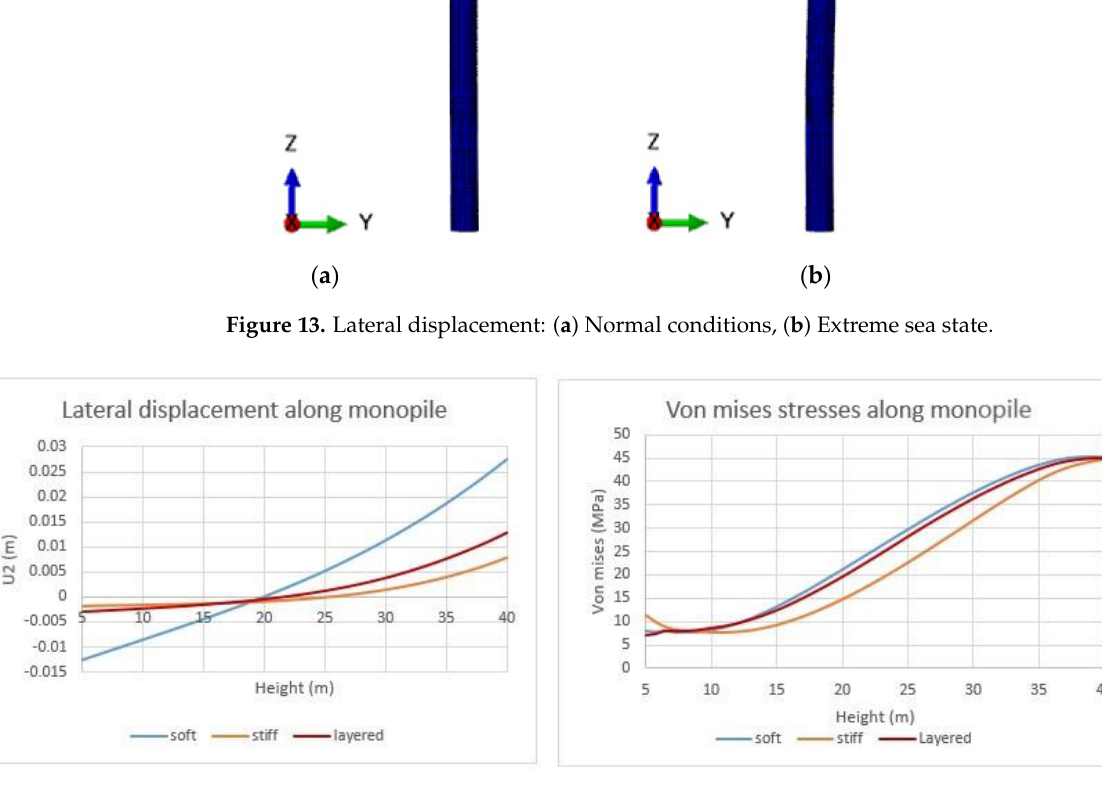
Figure 13. Lateral displacement: ( a ) Normal conditions, ( b ) Extreme sea state.